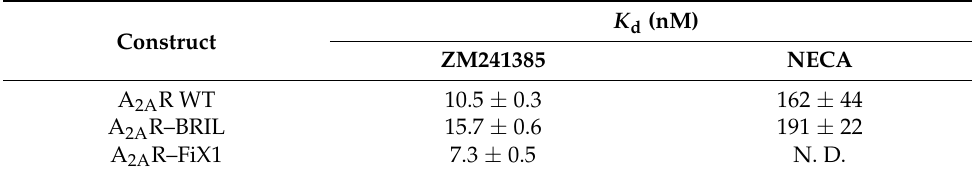
Table 2. Dissociation constants ( K d ) of A 2A R fused with or without fusion partner proteins by saturation binding assay. N.D. stands for not detected. Results are reported as the mean ± standard deviation for an n = 3 independent